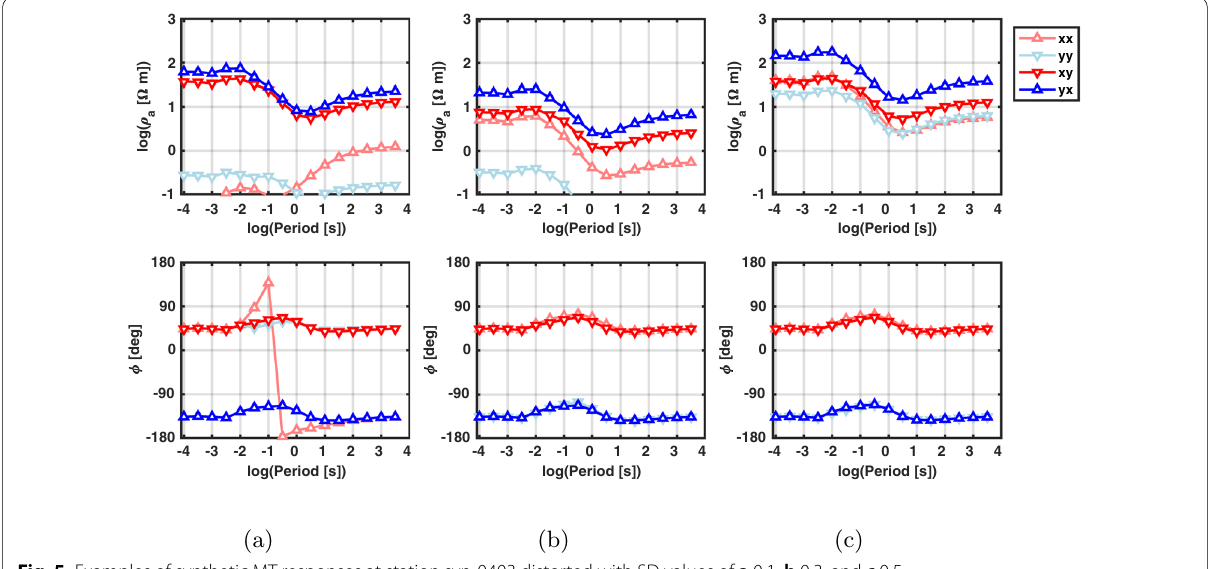
Fig. 5 Examples of synthetic MT responses at station syn‑0403 distorted with SD values of a 0.1, b 0.3, and c